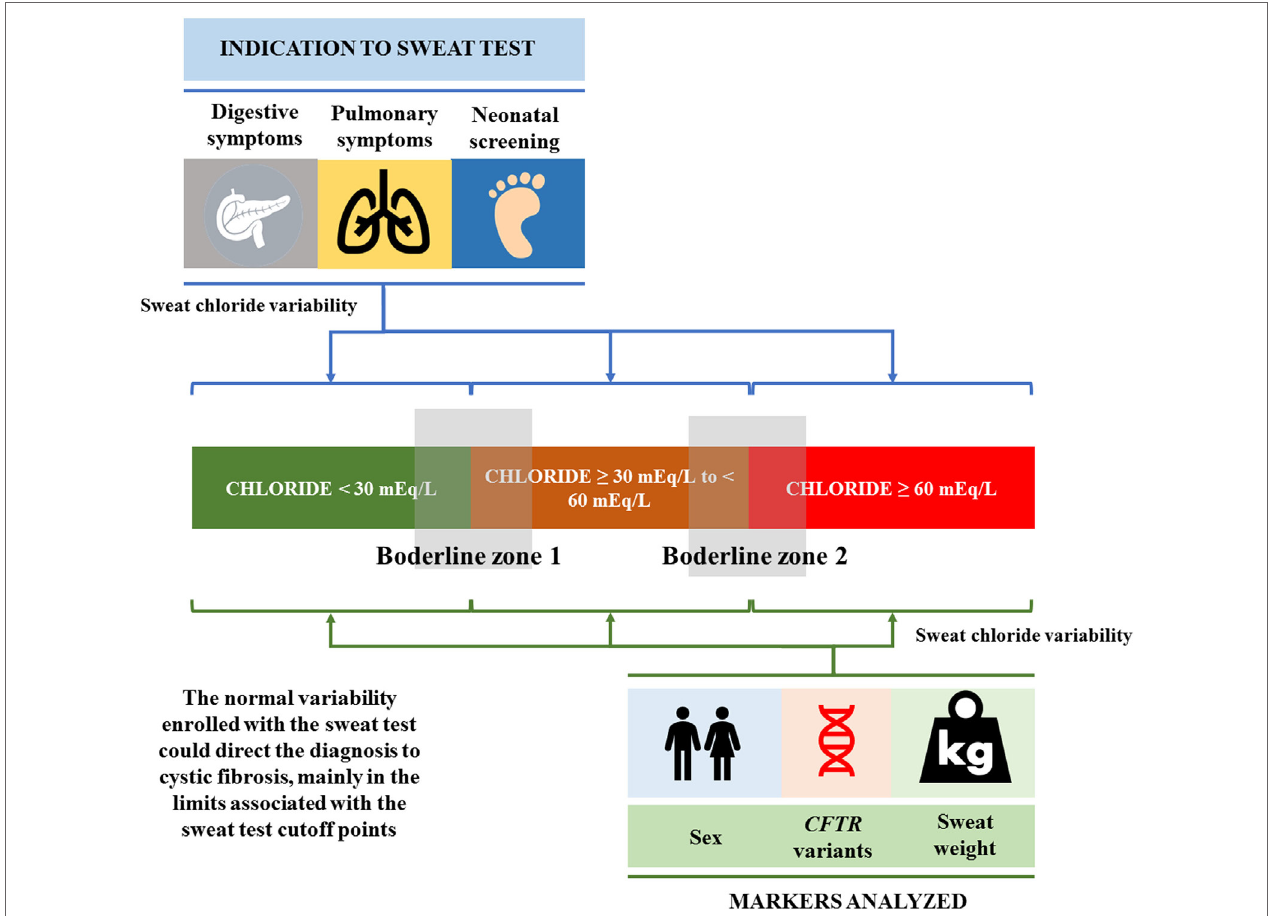
FigUre 5 | The normal variability enrolled with the sweat test, which could direct the diagnosis to cystic fibrosis, mainly in the limits (borderline zones 1 and 2) associated with the sweat test cutoff points. In addition, sex, CFTR mutation, sweat weight, digestive symptoms, pulmonary symptoms, and neonatal screening influenced the values achieved in the sweat test, and this influence is present in all possible sweat test classes: (i) < 30 mEq/L; (ii) ≥ 30 to < 60 mEq/L; and (iii) ≥ 60 mEq/L. CFTR , cystic fibrosis transmembrane